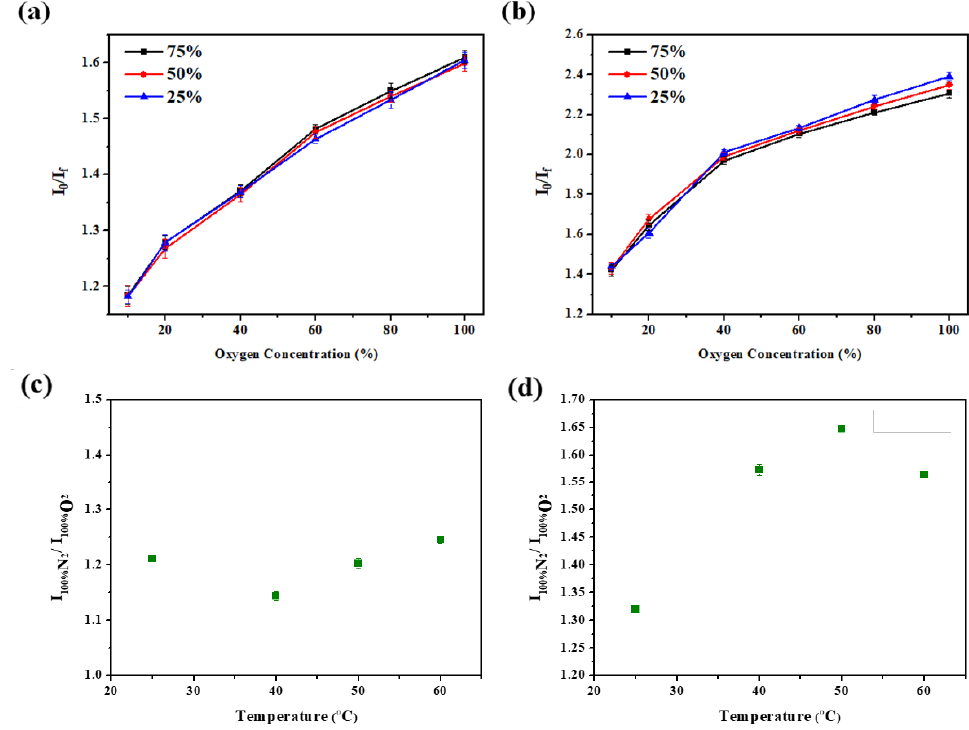
Figure 7. Responses of the gas sensor at different relative humidity and temperatures. Gas sensors are deposited on the glass ( a , c ) and filter paper ( b , d ) substrates.